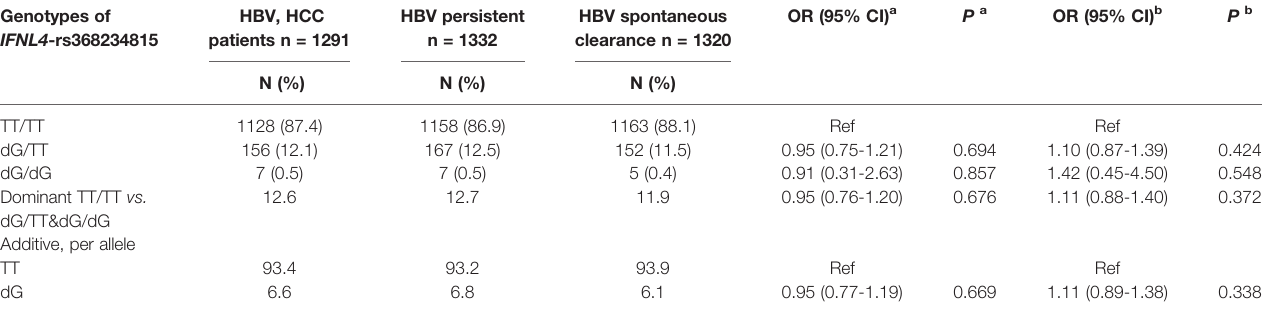
TABLE 7 | IFNL4 genotype is not associated with an increased risk of HCC in HBV-infected patients in China. Genotypes of IFNL4